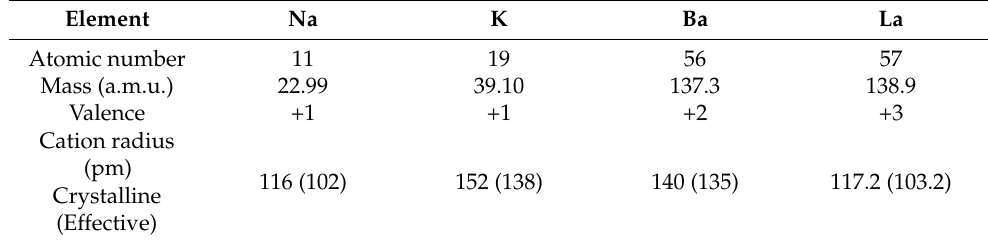
Table 4. Atomic number, mass valence and ionic radius (crystalline and effective, assuming a coordination number of six [36]) of the cations involved in the FLIER